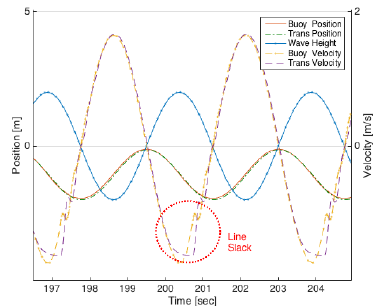
Figure 5. Hydrodynamics for the buoy and translator under harmonic waves. In the figure, slack is shown to occur in the guiding line between the buoy and the translator. shown to occur in the guiding line between the buoy and the